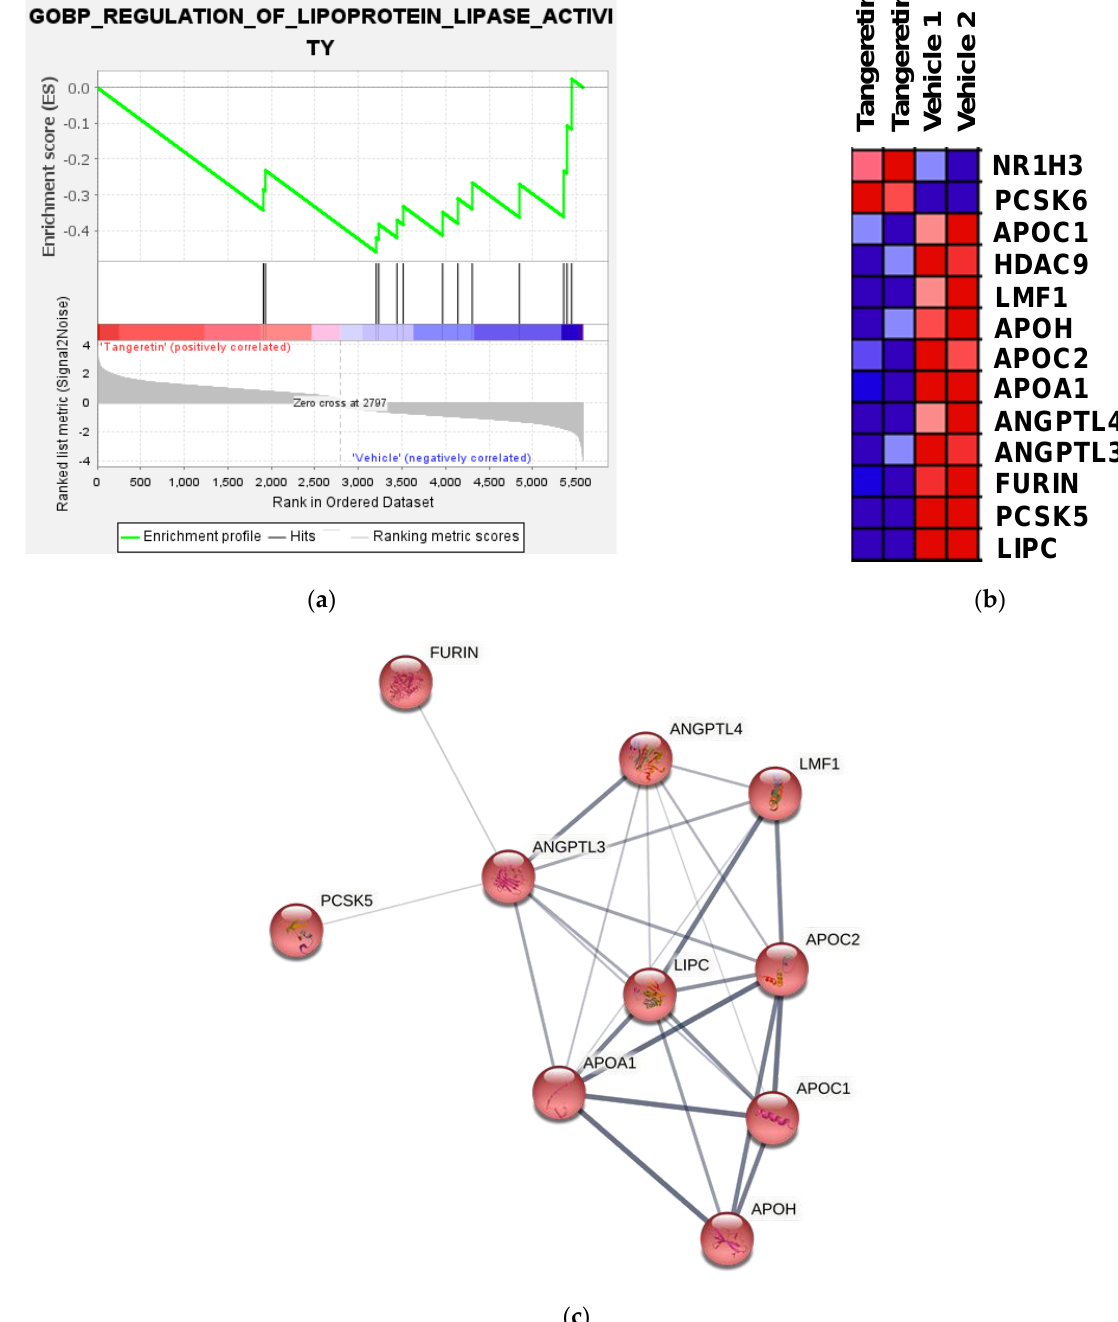
Figure 3. Pathway enrichment, GSEA, and prediction of protein–protein interactions for DEGs in response to tangeretin treatment. The differentially expressed genes (DEGs) in tangeretin-treated HepG2 cells were analyzed by a human genome-wide microarray as described in the Materials and Methods. ( a ) Gene set enrichment analysis (GSEA) demonstrates that the GO BP signature “Enrichment plot: GO BP Regulation of Lipoprotein Lipase Activity” (GO:0051004) gene set is enriched with the DEGs of tangeretin-treated cells. The barcode plot represents the position of the genes in the gene set. The horizontal bar in graded color from red to blue indicates positive and negative regulation by tangeretin. The vertical axis in the lower plot indicates the ranked list metric. ( b ) The DEGs in the gene set of GO:0051004 in response to tangeretin (40 μM) treatment. ( c ) Predicted protein–protein interaction for tangeretin-downregulated genes associated with regulation of LPL activity. The corresponding genes were uploaded to the STRING interaction database. Disconnected nodes were omitted, and line thickness indicates the strength of the data supporting the connections.